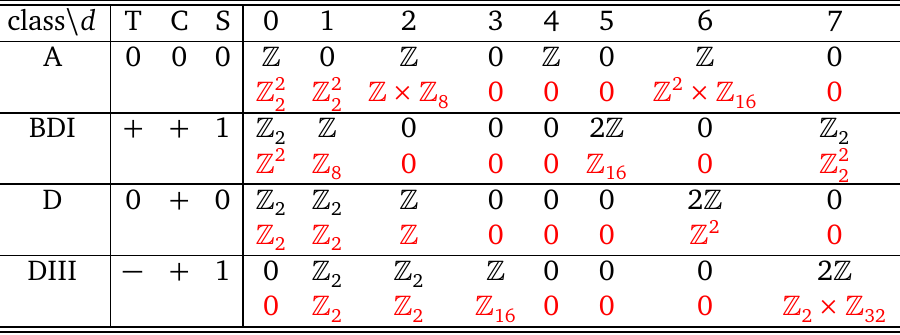
Figure 25: Topological classes of the free-fermion tenfold classification (black, see Fig. 18) compared with the results of cobordism invariance (red) for topological theories of interacting